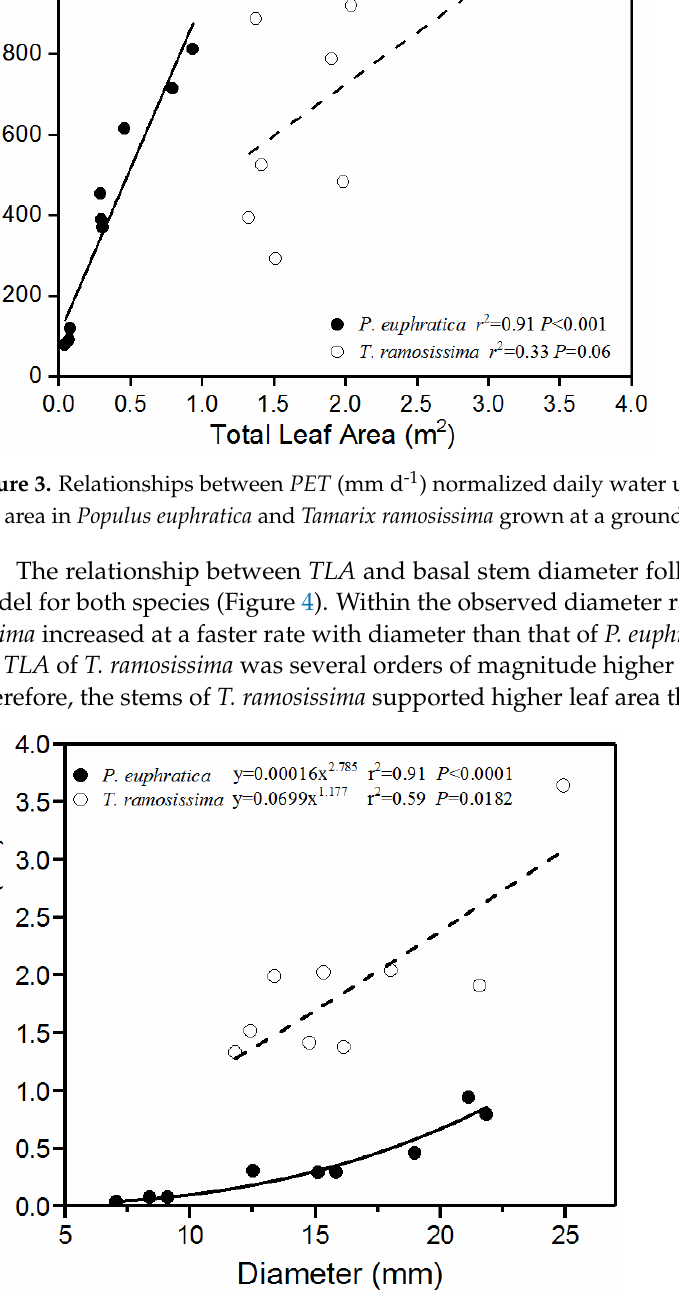
Figure 4. Relationship between leaf area and basal stem diameter in Populus euphratica and Tamarix ramosissima individuals.